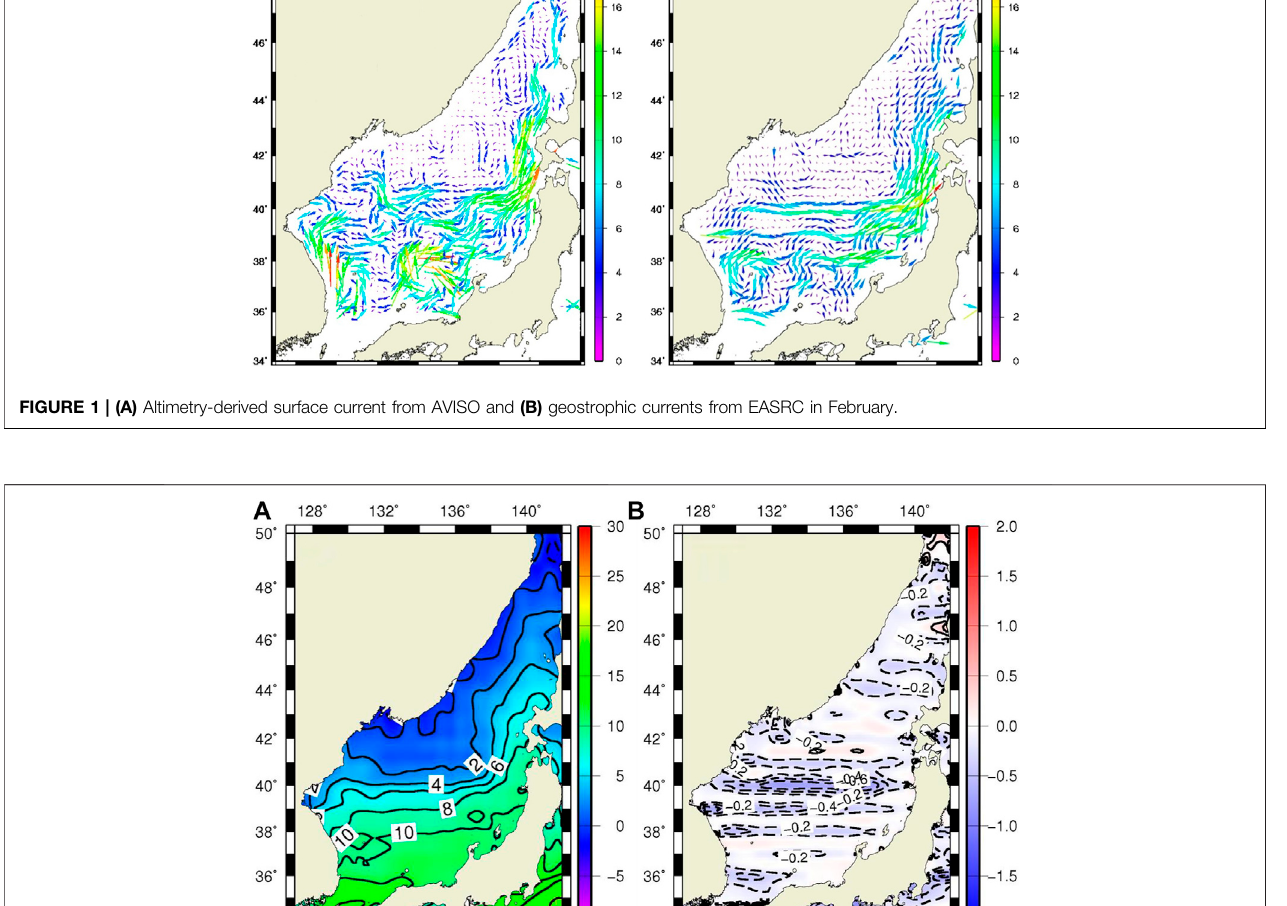
Frontiers in Earth Science |